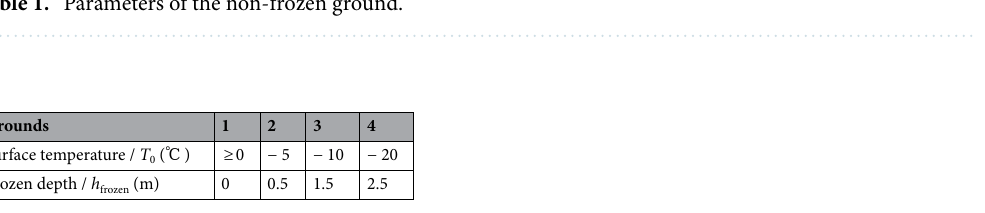
Table 1. Parameters of the non-frozen ground.